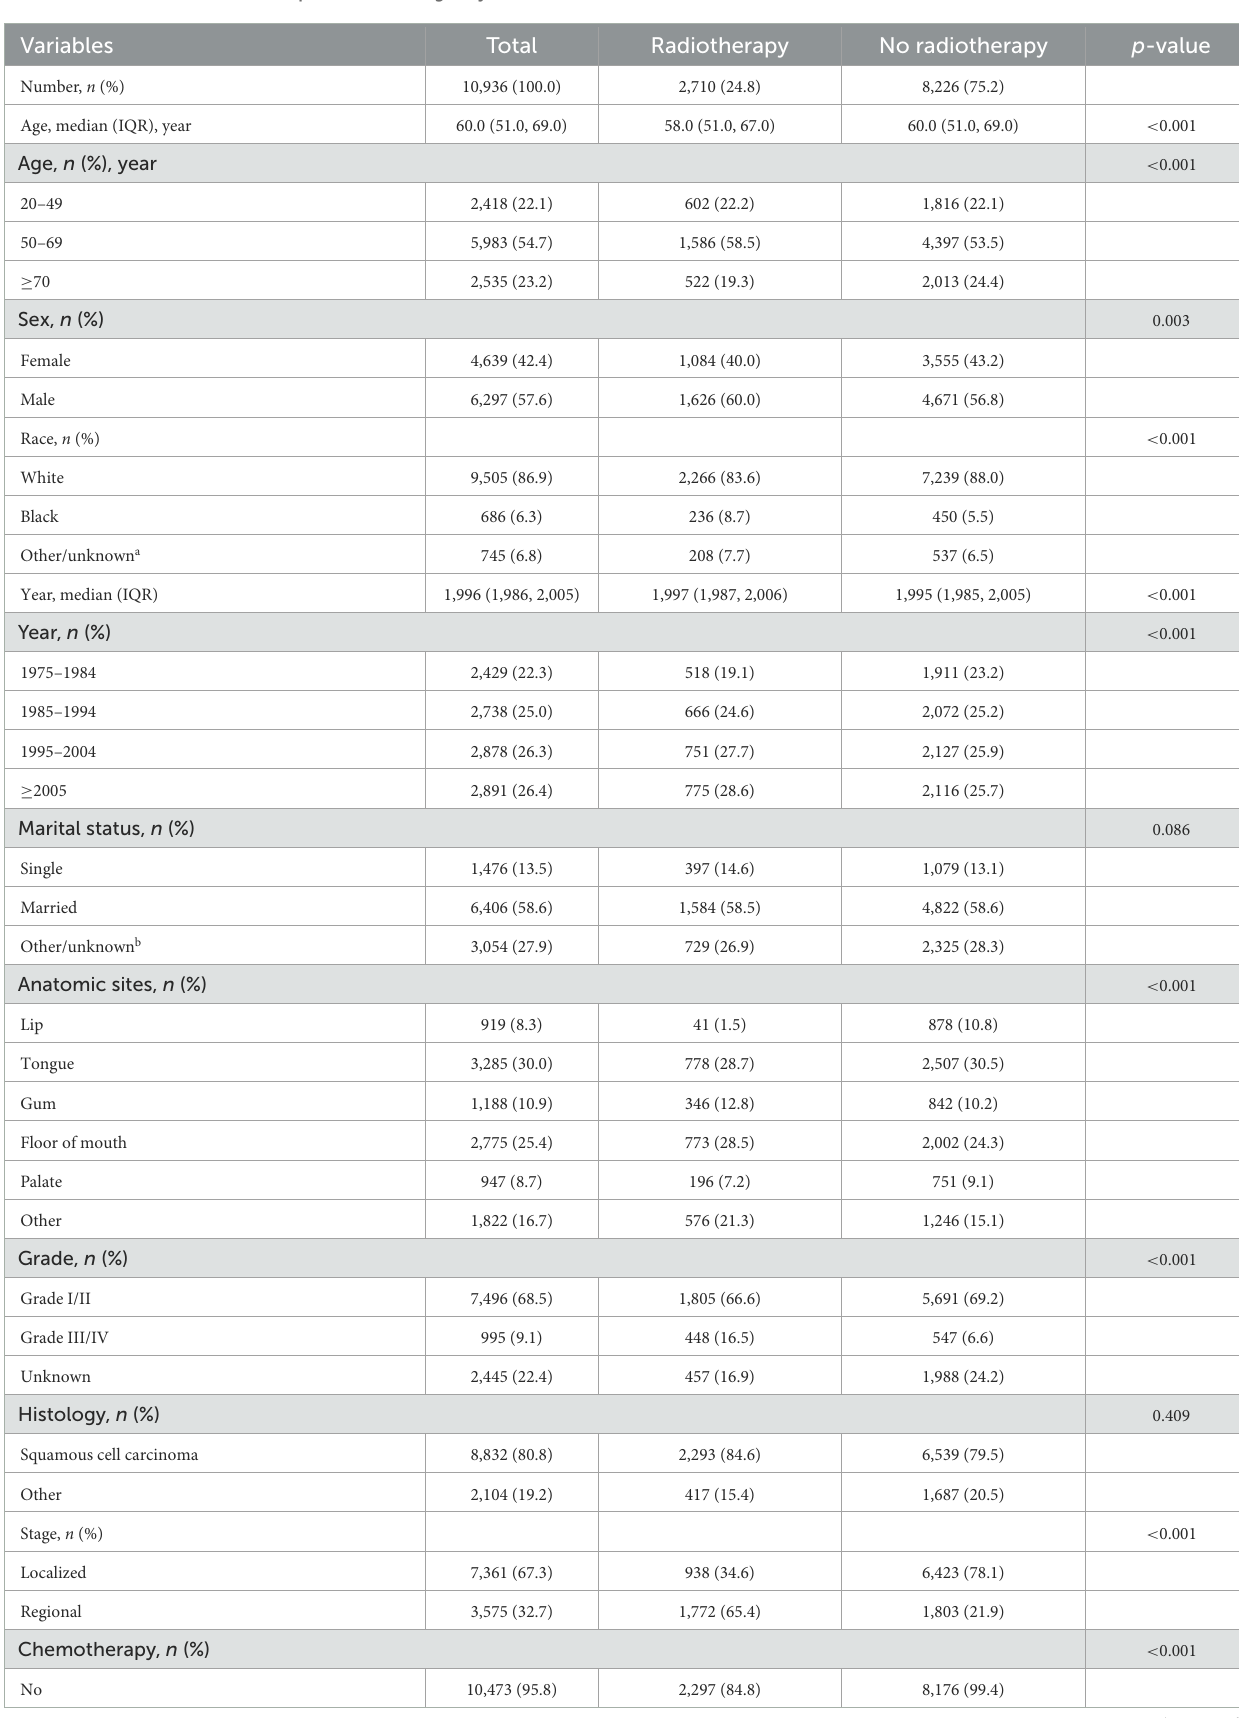
TABLE 1 Baseline characteristics of patients with surgically treated